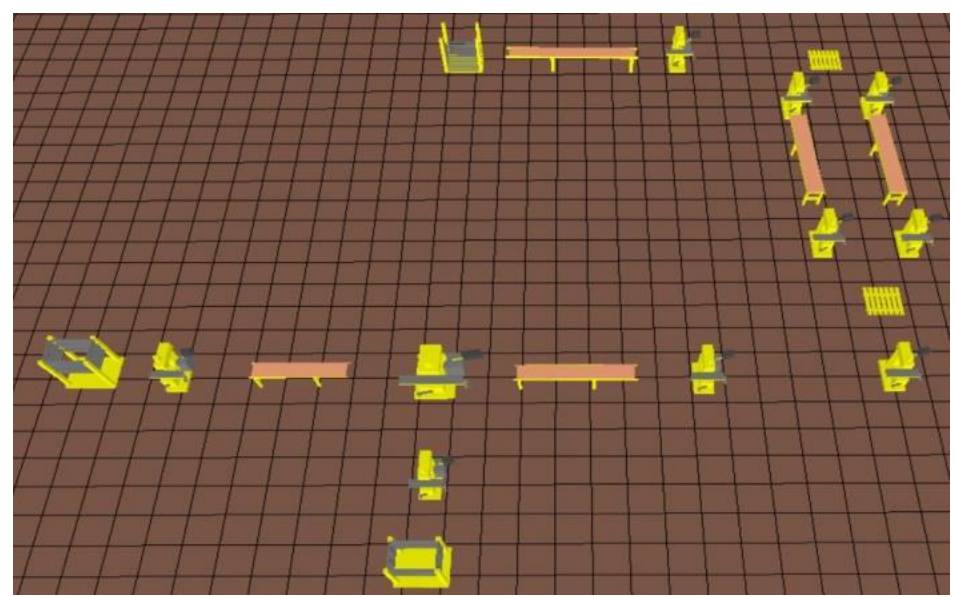
Figure 5: Conveyers handling system